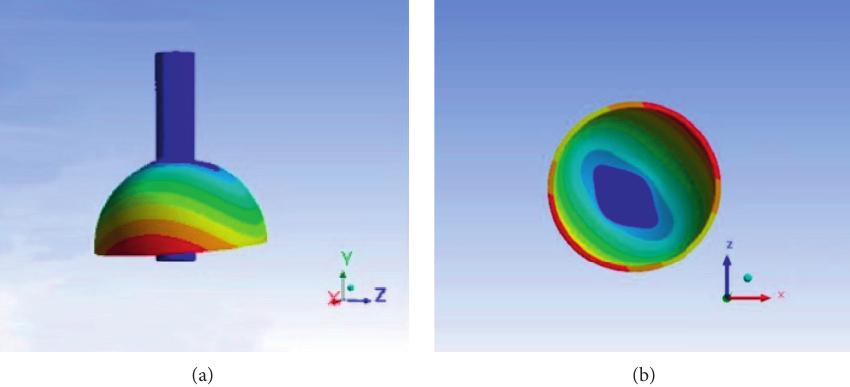
Figure 8: The plane view and bottom view of the hemispherical resonator’s deformation.